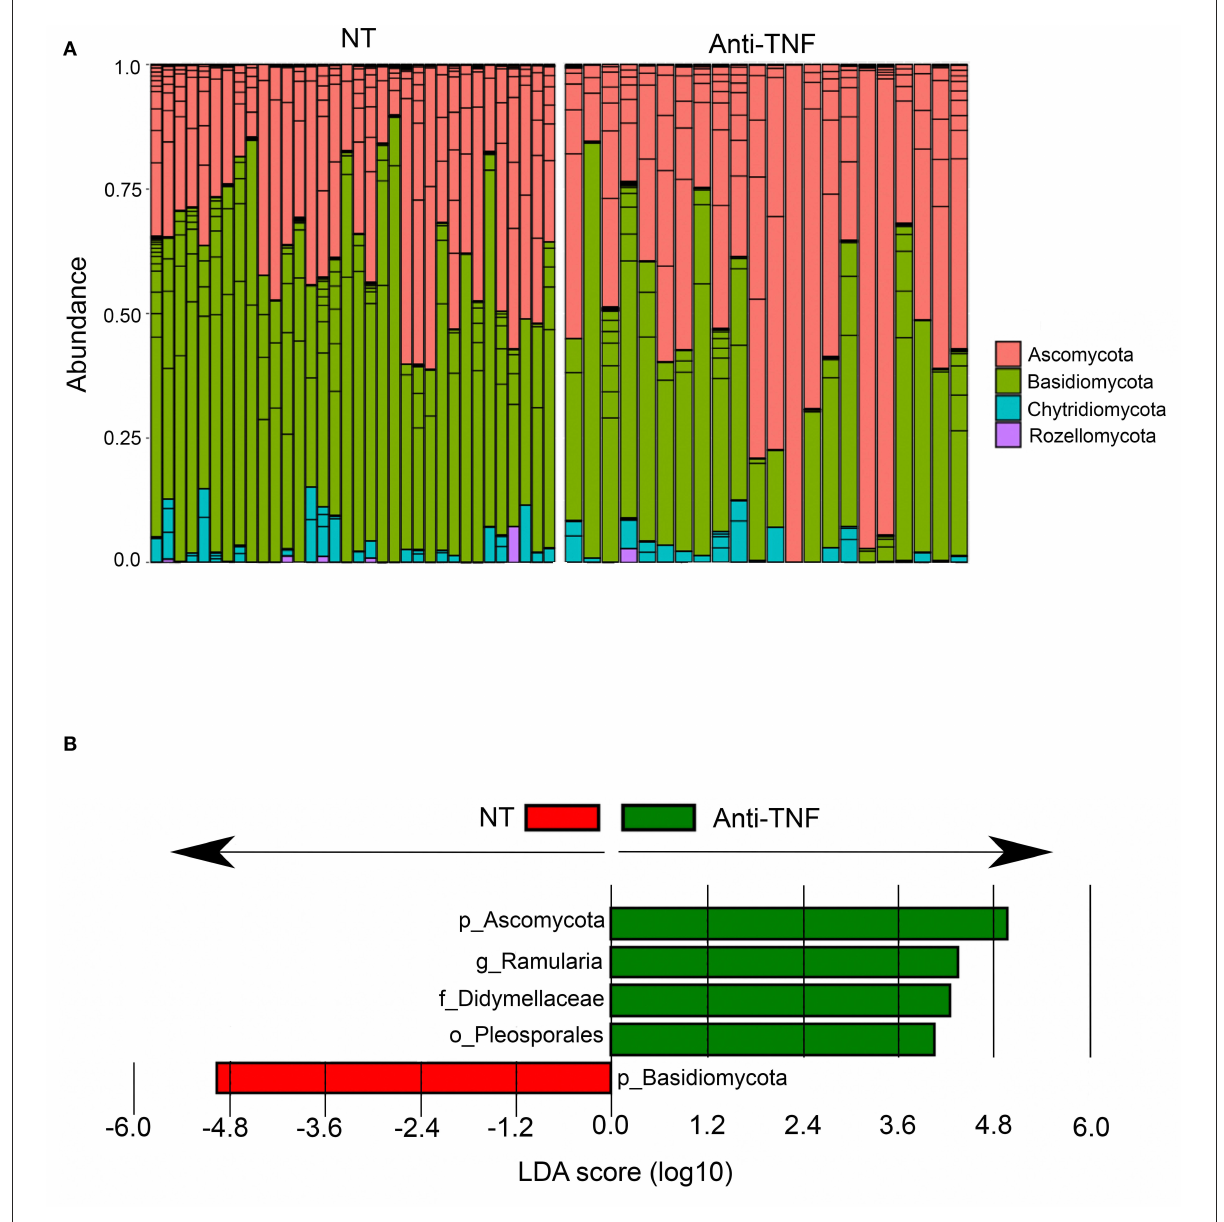
FIGURE6 Differentially abundant fungal taxa between Crohn’s disease (CD) patients currently using anti-TNF agents (Anti-TNF) ( n = 11) compared to CD patients with no medical treatment (NT) ( n = 18). (A) Relative abundance of fungal phyla in CD patients with no medical treatment (NT) and anti-TNF treated CD patients. (B) Fungal taxa overrepresented in anti-TNF-treated CD patients (green) and in CD patients with no medical treatment (NT) (red) illustrated in a histogram with Linear Discriminant Analysis (LDA) score computed using linear discriminant analysis effect size